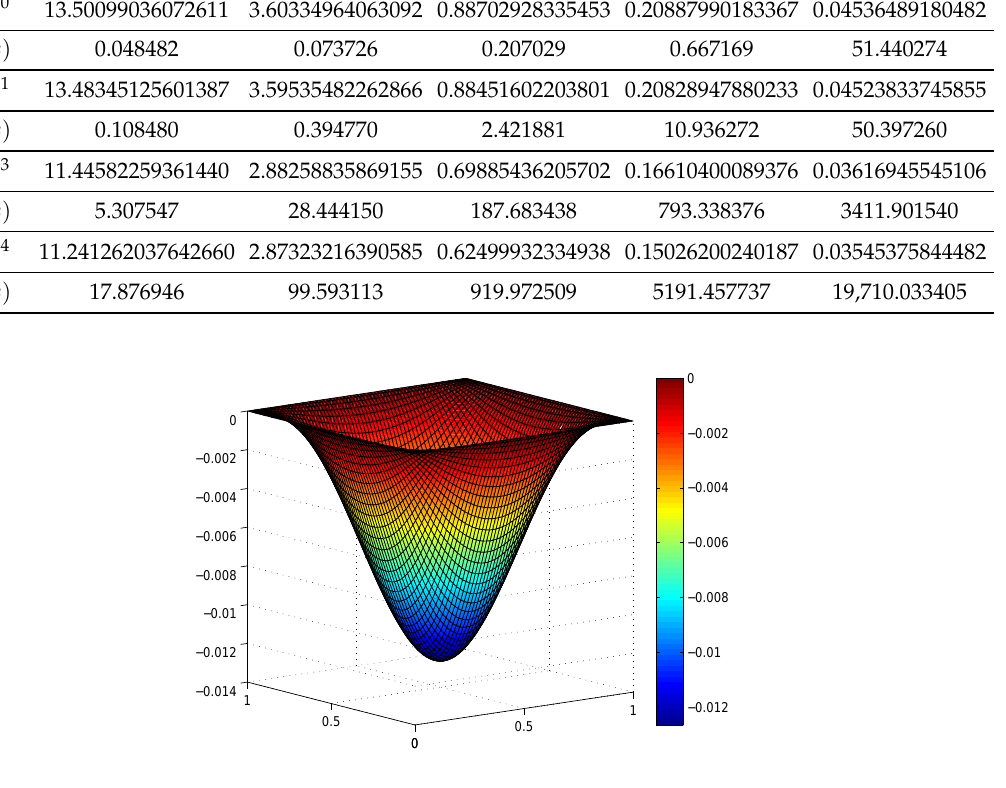
Figure 1. The numerical solution u h with κ =